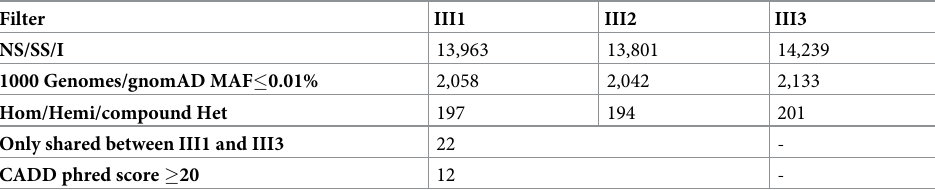
Table 1. Prioritization of variants identified by exome sequencing.